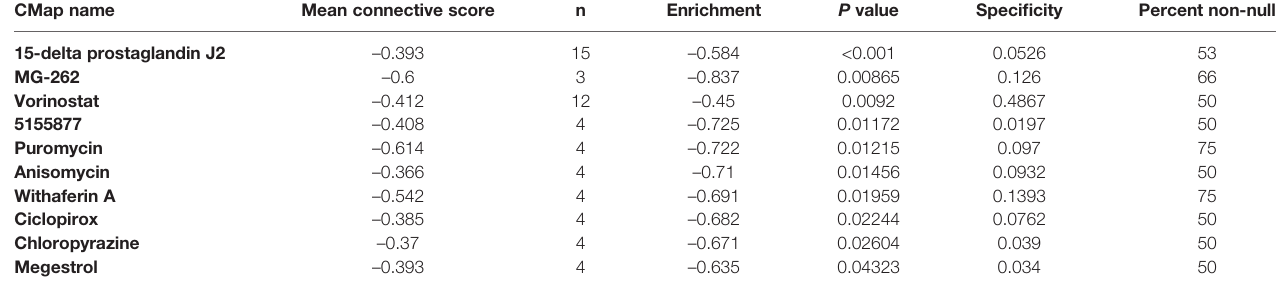
TABLE 3 | Connectivity map analysis results.